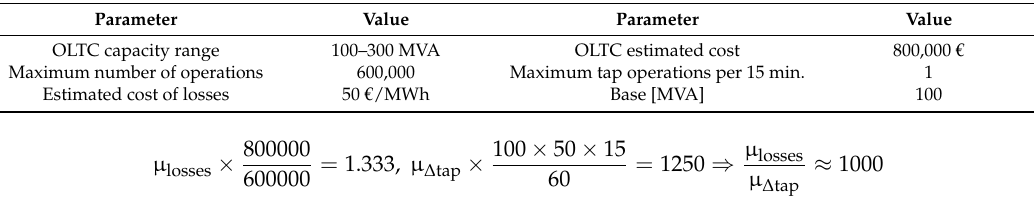
Table A3. Tap operation cost estimation